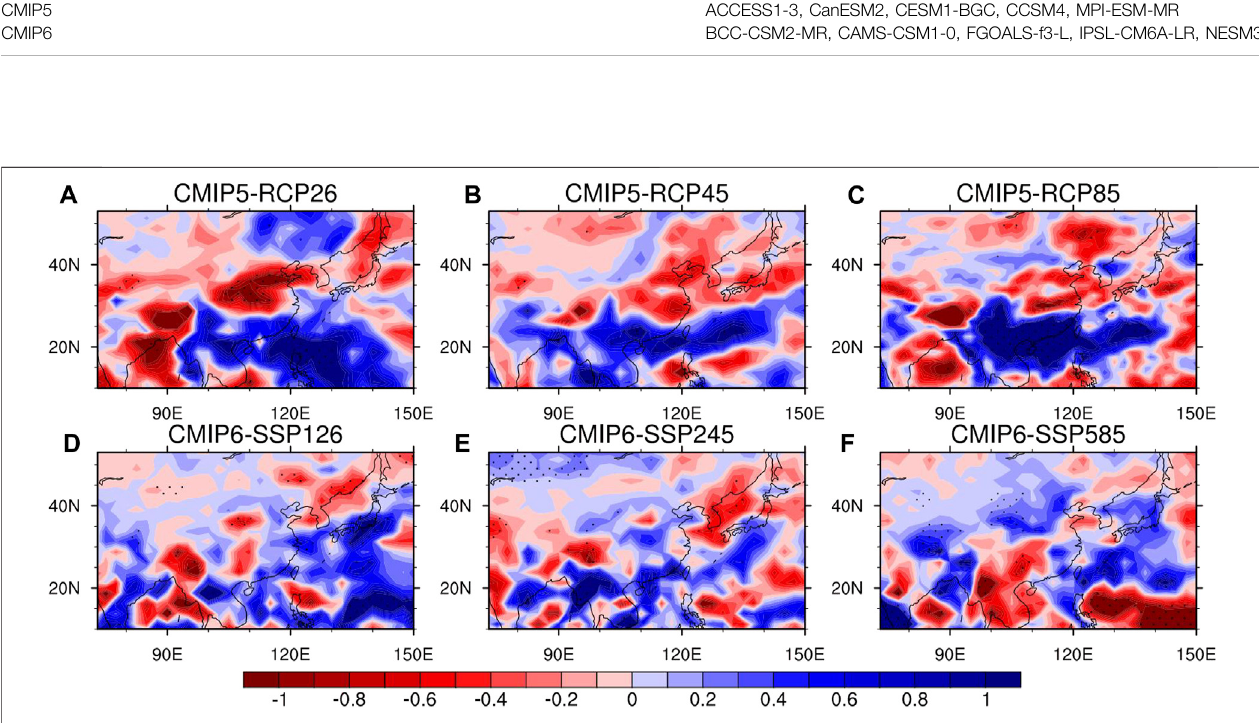
FIGURE3| Thechangesfortheprecipitationanomalies(mm/day)duringstrongEPeventsinthefollowingsummerforthedifferentRCPsexperimentsinCMIP5( A . RCP2.6, B . RCP4.5, C . RCP8.5) and SSPs experiments in CMIP6 ( D . SSP1-26, E . SSP2-45, F . SSP5-85).